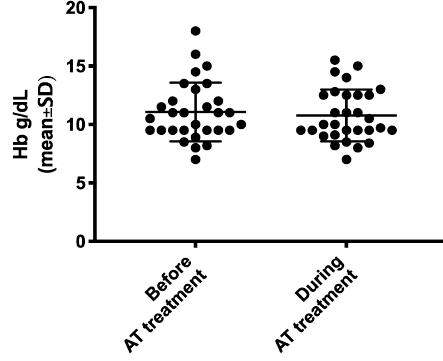
Figure 1. Distribution of hemoglobin (Hb) levels before and during AT.